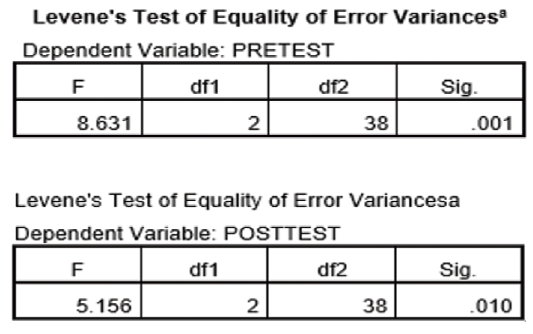
Table 4. Levene’s test for equality of variances